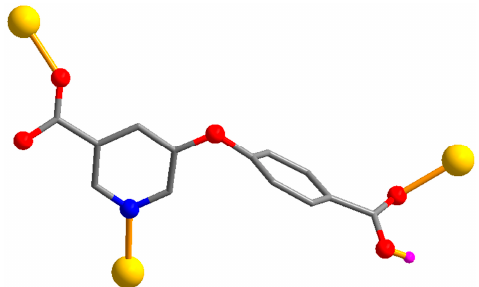
Figure 1. Different structural representations of 1 . ( a ) Connectivity and coordination sphere of the Fe1 center; hydrogen atoms are not shown with an exception of H in COOH. Symmetry operators: i = – x + 1, – y + 1, – z ; ii = x , y , z – 1; iii = – x + 1, – y +1, – z + 1; iv = – x + 1/2, y + 1/2, – z + 1/2; v = x + 1/2, – y + 1/2, Topological view of a 3D coordination polymer displaying a 3,6-connected binodal underlying net of the rtl (rutile) topological type. View along the c axis; colors: centroids of 3-connected μ 3 -Hcpna – Scheme 1. The coordination mode of Hcpna – block in 1 . nodes (gray), 6-connected Fe1 nodes (orange balls).